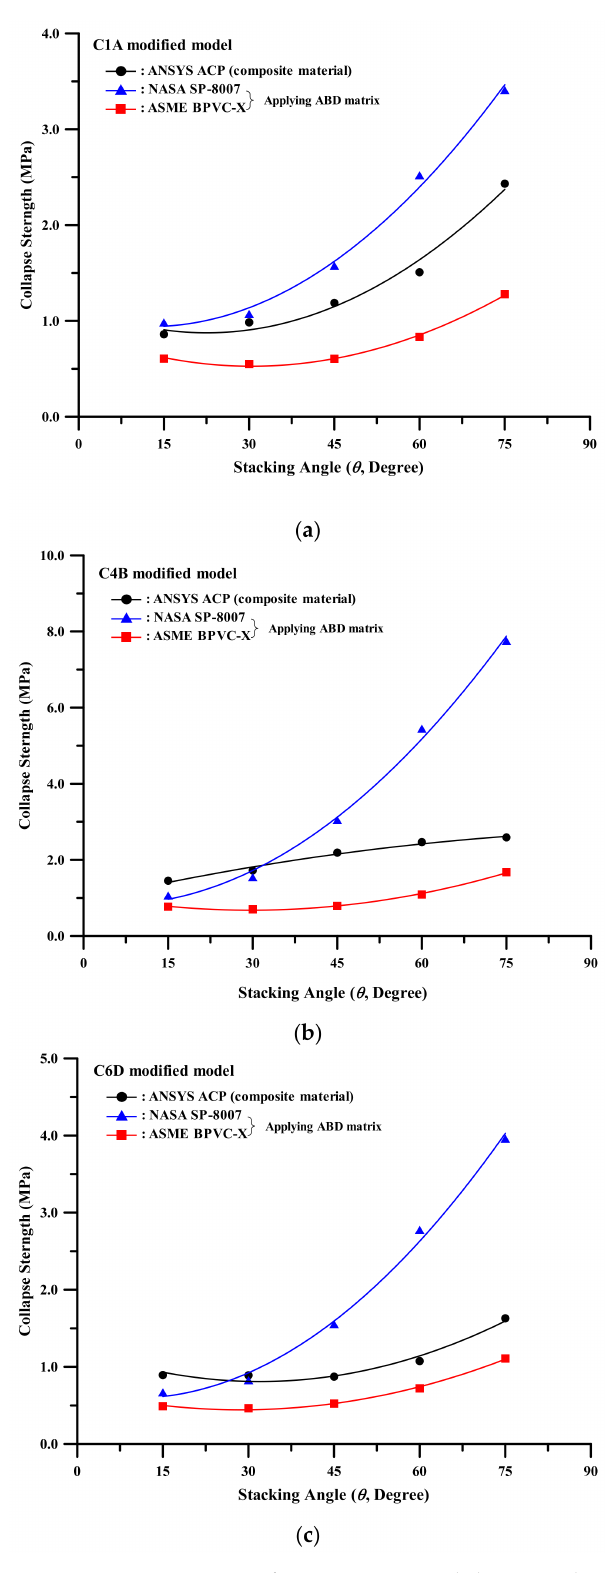
Figure 15. Comparison of ANSYS ACP and design codes. ( a ) Modified C1A, ( b ) Modified C4B, ( c ) Modified